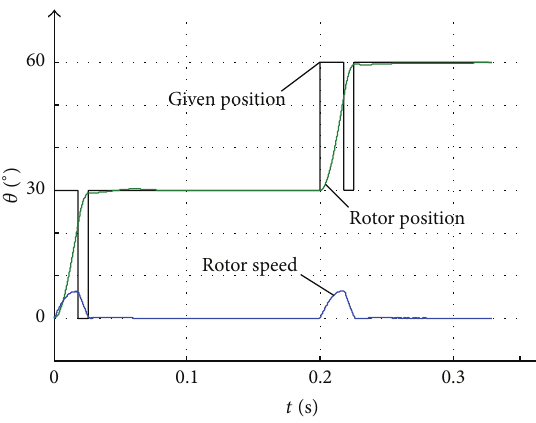
Figure 9: Position and speed curve under time optimization.